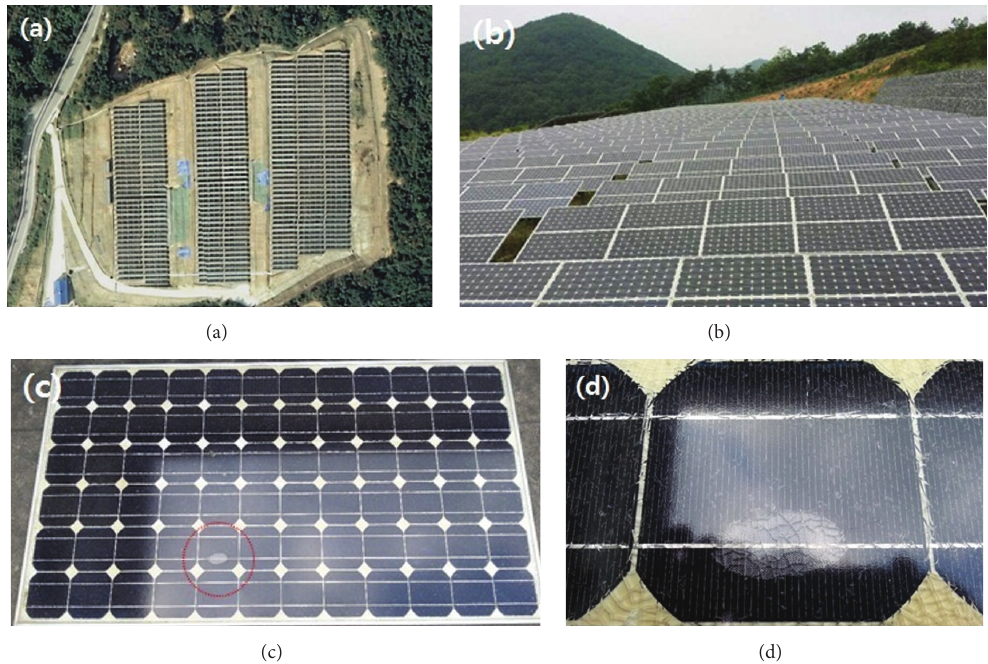
Figure 1: Field-aged PV module sample (a), (b); Chilgok solar power plant sample (c); and (d) degradation area for analysis.